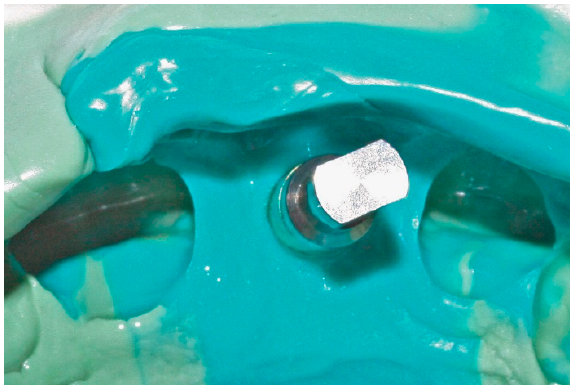
Figure 2. Implant level impression coping in place.